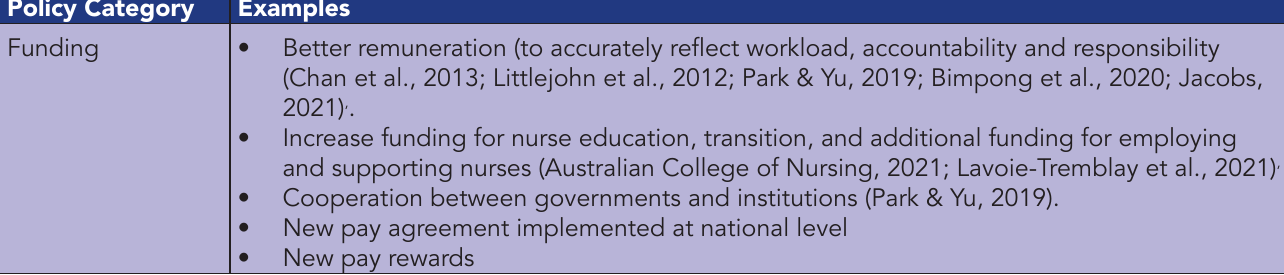
Table 12: Select Policy Categories and Recommendations Policy